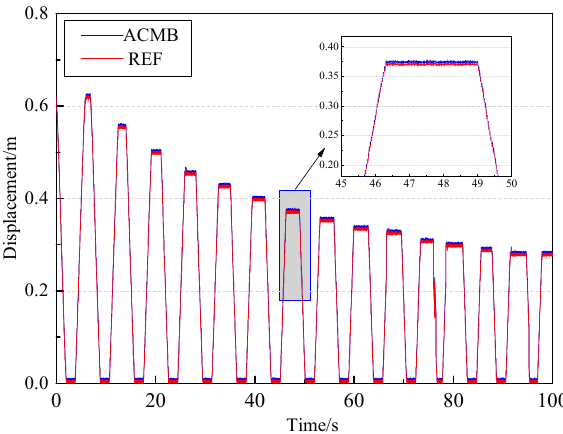
Figure 13. Displacement response curves of cylinder.